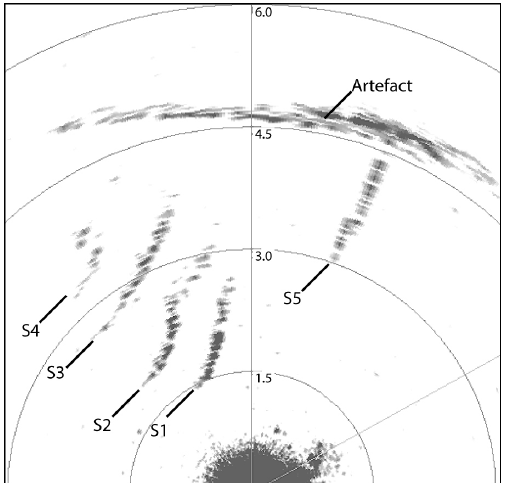
Figure 7. Screenshot of the record from the horizontally looking sonar (Sonar Tritech, 625kHz, 6m range) mounted on the ROV (Dive 05, 14:37:27UTC). The image shows the five bubble streams S1 to S5 at cluster C5 at the western edge of the dive